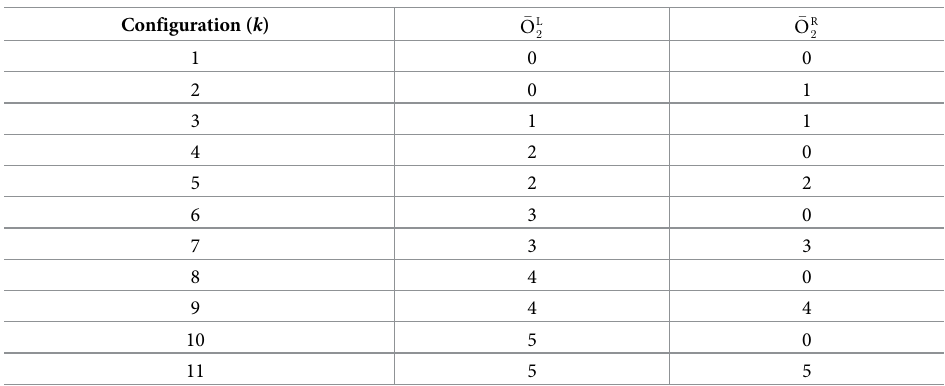
Table 3. Experimental configurations used for data generation. The different configurations recreate both symmet- ric and gradient configurations in low, medium and high oxygenated conditions (these values have to be compared with the model-associated ones, Eq